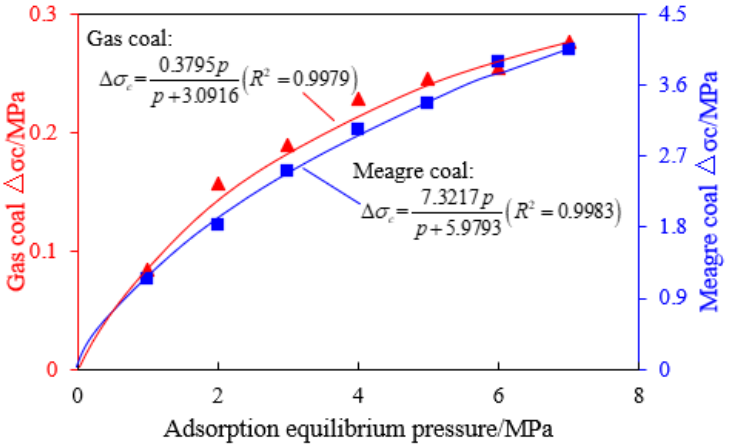
Figure 5. Reduction in compressive strength of coal sample vs. methane adsorption equilibrium pressure.